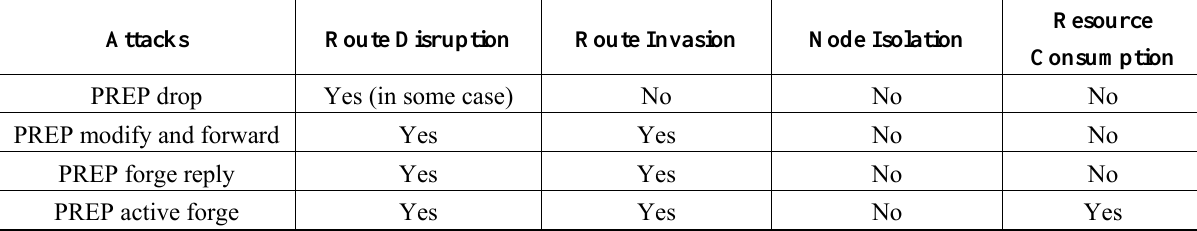
Table 5. Misuse of PREP messages and achievable misuse goals.